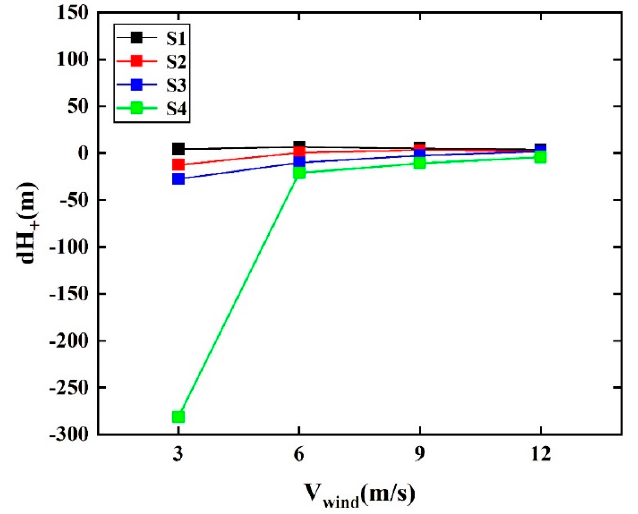
Figure 5. The rising height difference dH + between the moving source scheme and the stationary source scheme at different wind speeds in the V2 − T2 scenario.